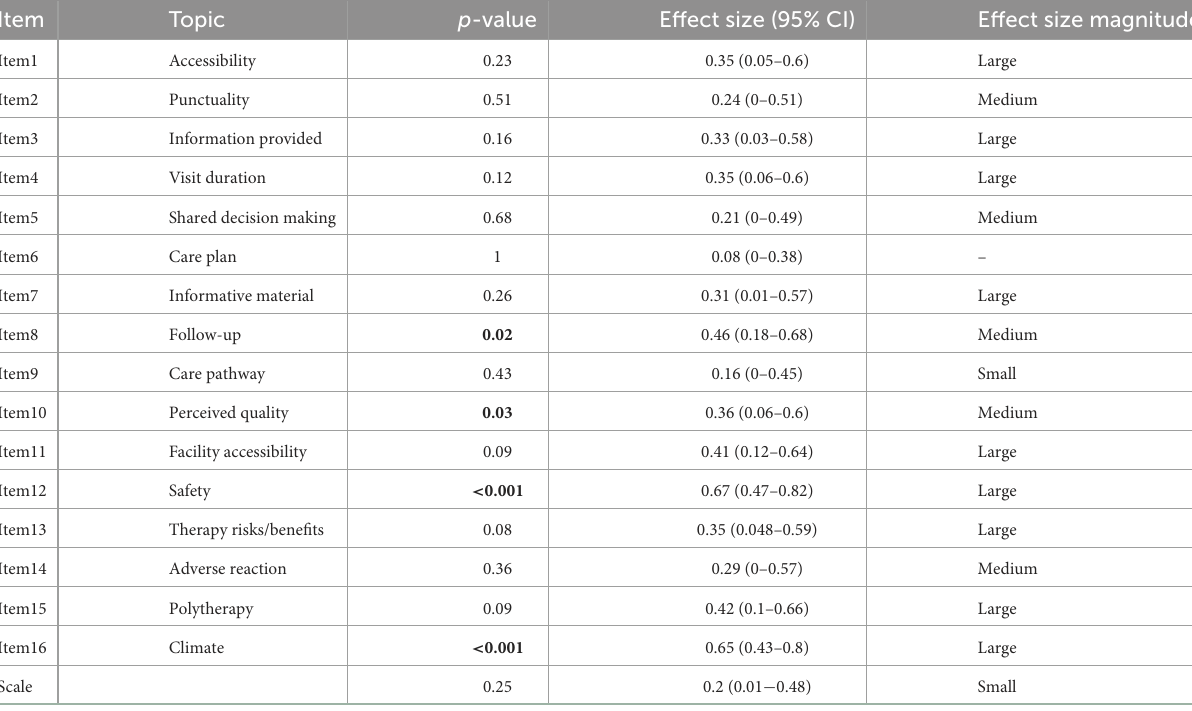
TABLE 5 Results of comparison between responses to each item from the professionals’ and patients/caregivers’